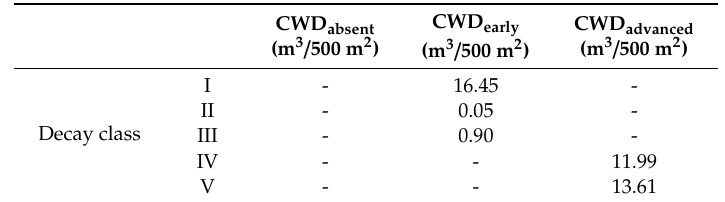
Table 1. The volume (m 3 ) of coarse woody debris in various decay classes at study sites in the Białowie˙za old-growth forest. The five-class scale of decomposition of fallen logs was based on Renvall [30]. CWD: coarse woody